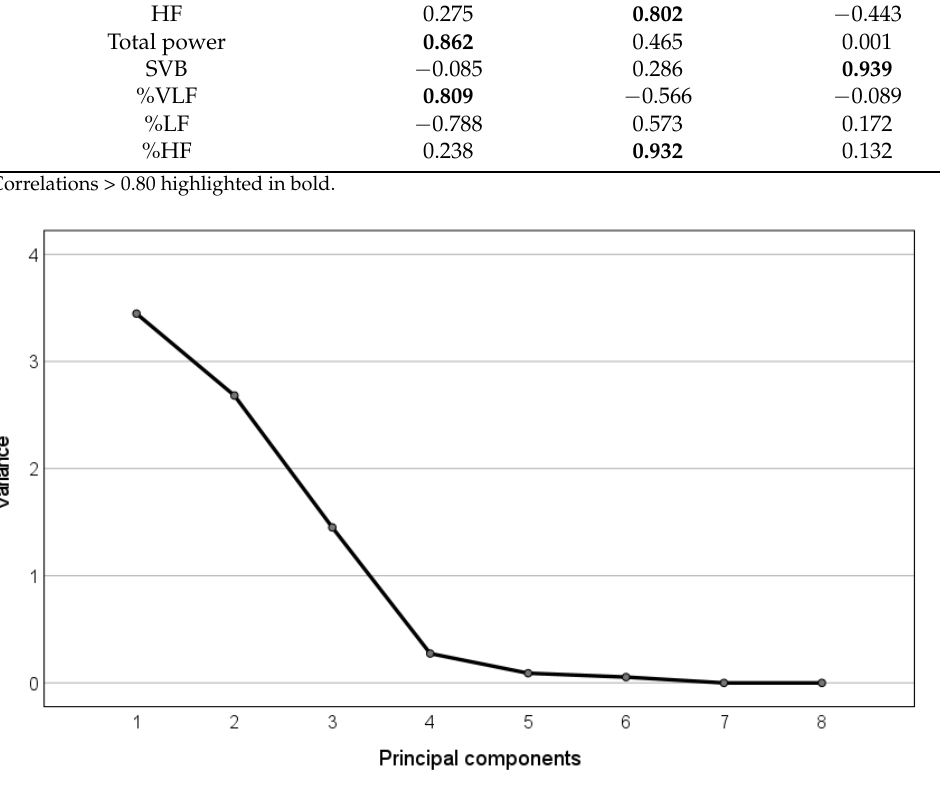
Table 2. Dimension reduction of frequency-domain features of the FHRV.